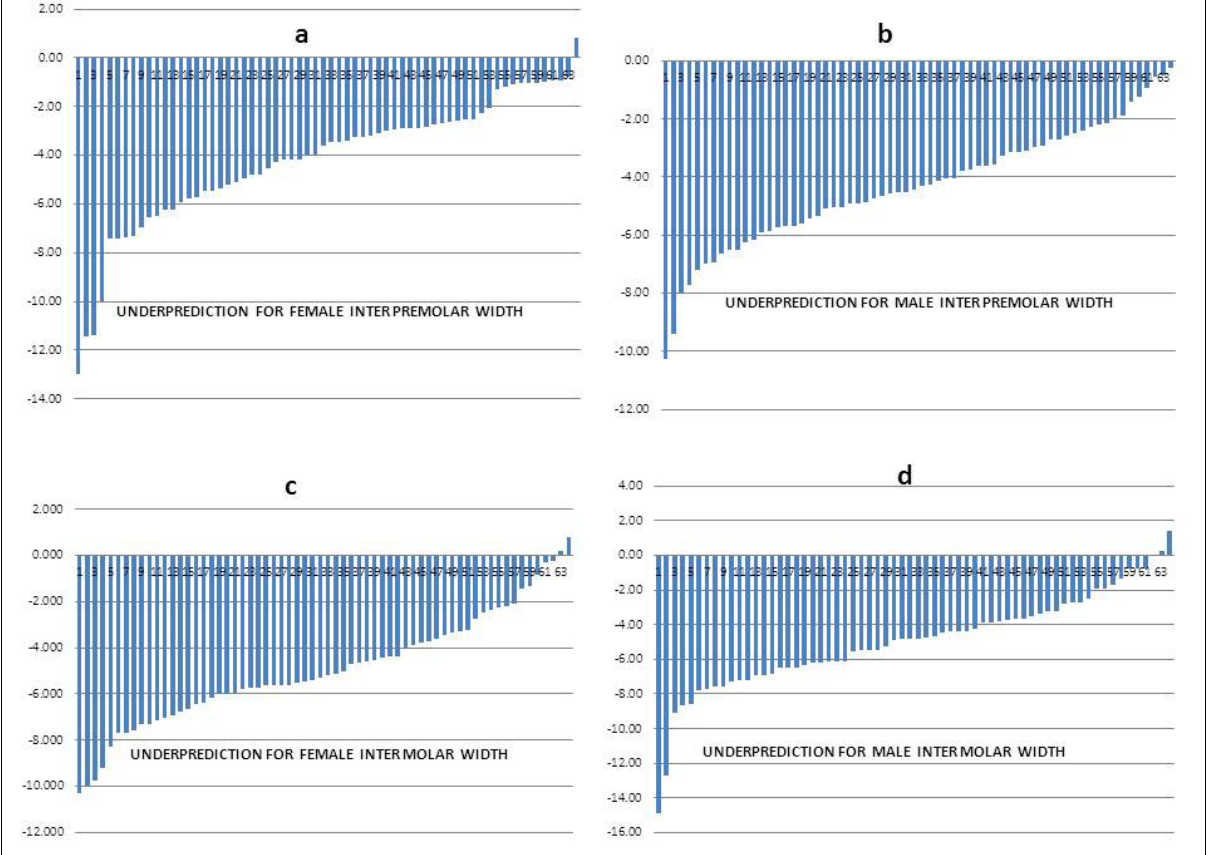
Figure 4. Pont’s underprediction in the maxillary arch: (a) interpremolar width in females, (b) interpremolar width in males, (c) intermolar width in females, (d) intermolar width in